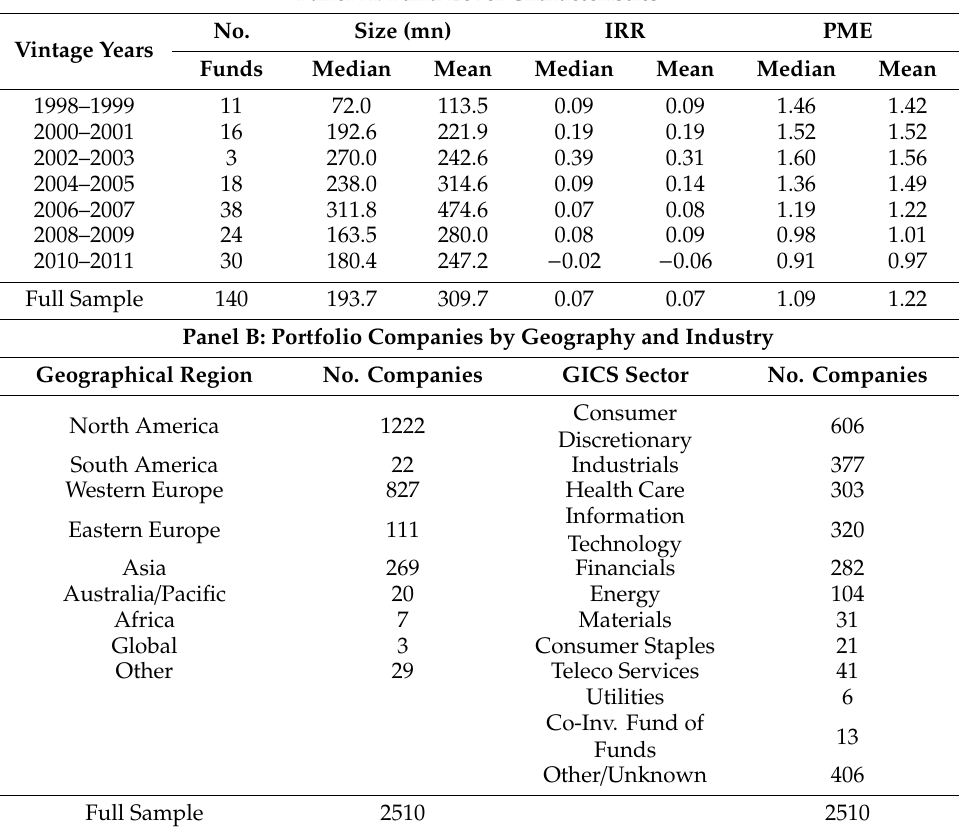
Table 1. Size and performance characteristics of sampled funds. Panel A: Fund Level